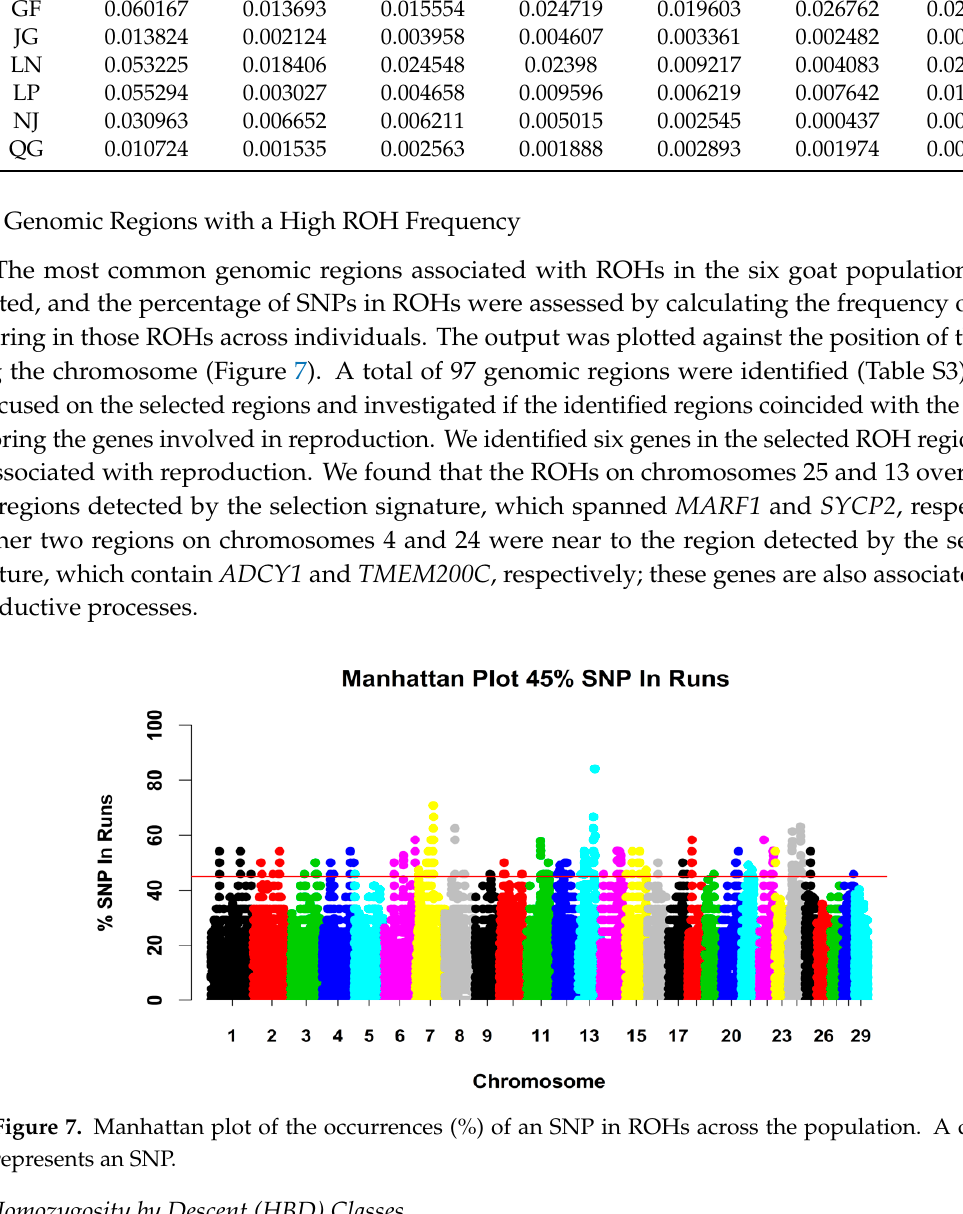
Figure 8. Partitioning of the genome in different homozygosity by descent (HBD) classes in six goat populations. The results are plotted for 20 randomly selected individuals per population. The height